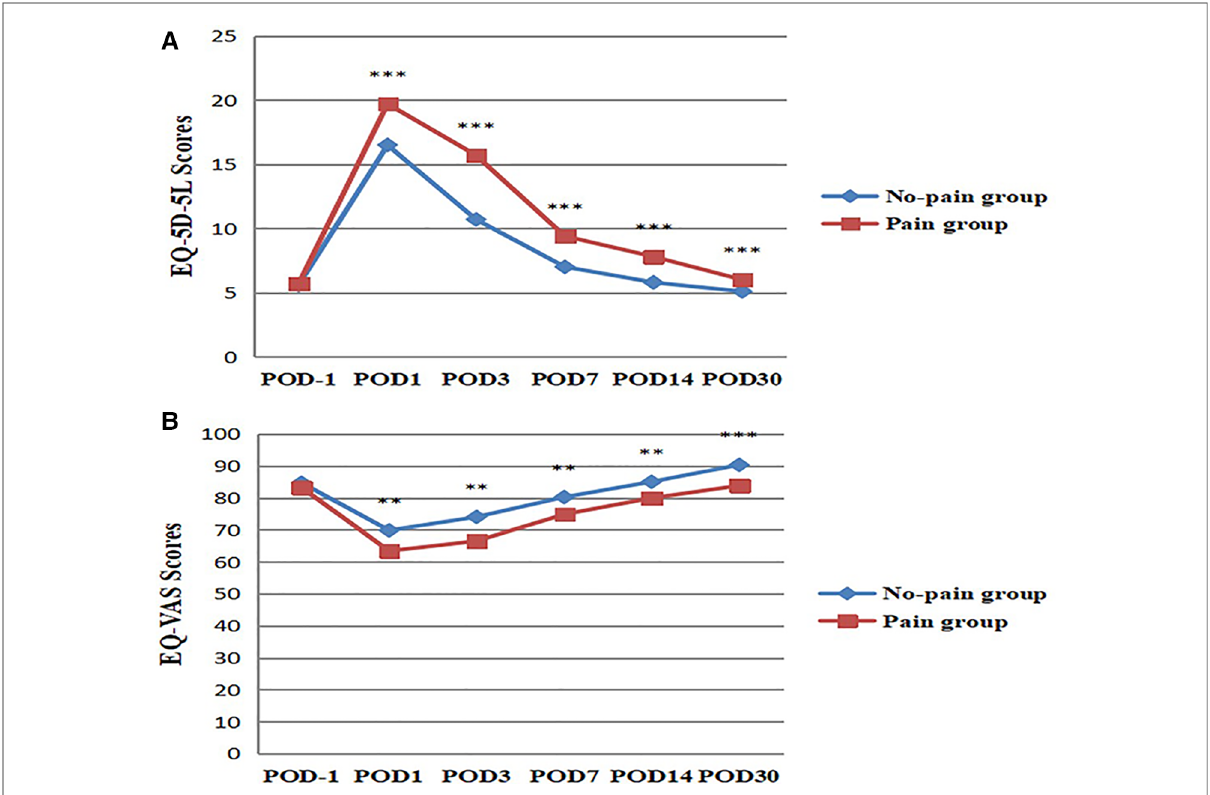
FIGURE 3 Comparison of EQ-5D scores between pain and non-pain patients. ( A ) EQ-5D-5L scores were compared between the two groups. *** P <0.001, the difference was statistically signi fi cant. ( B ) EQ-VAS scores were compared between the two groups. ** P <0.01, *** P <0.001, the difference was statistically signi fi cant. POD=Postoperative